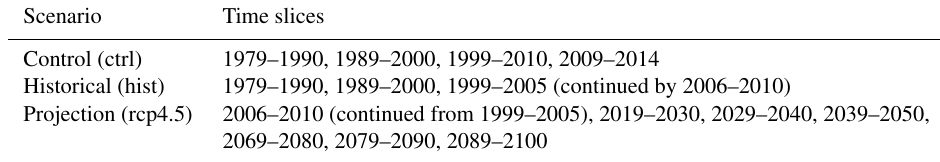
Table A5. Description of time slices generated in the WASCAL WRF ensemble experiment, including spin-up period.